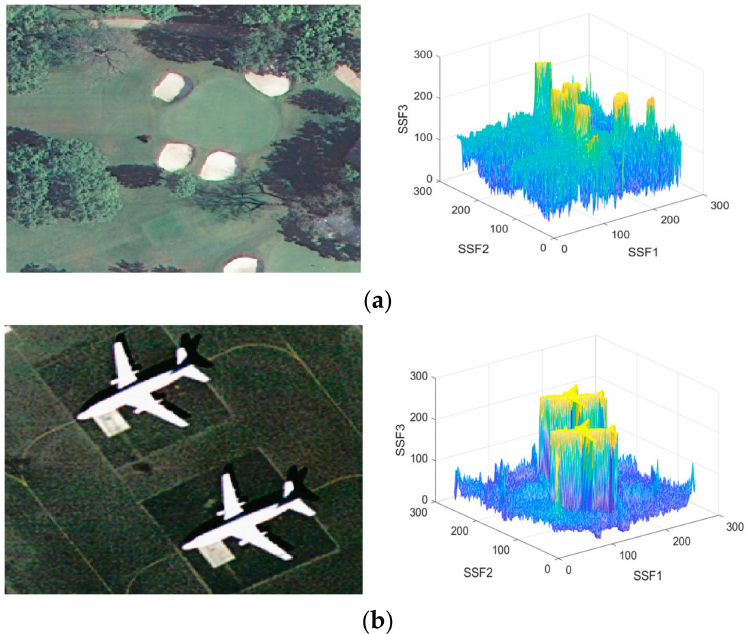
Figure 5. Spectral–spatial feature representation: ( a ) original image (left) and corresponding SSF extraction (right) from UCM dataset; ( b ) original image (left) and corresponding SSF extraction (right) from